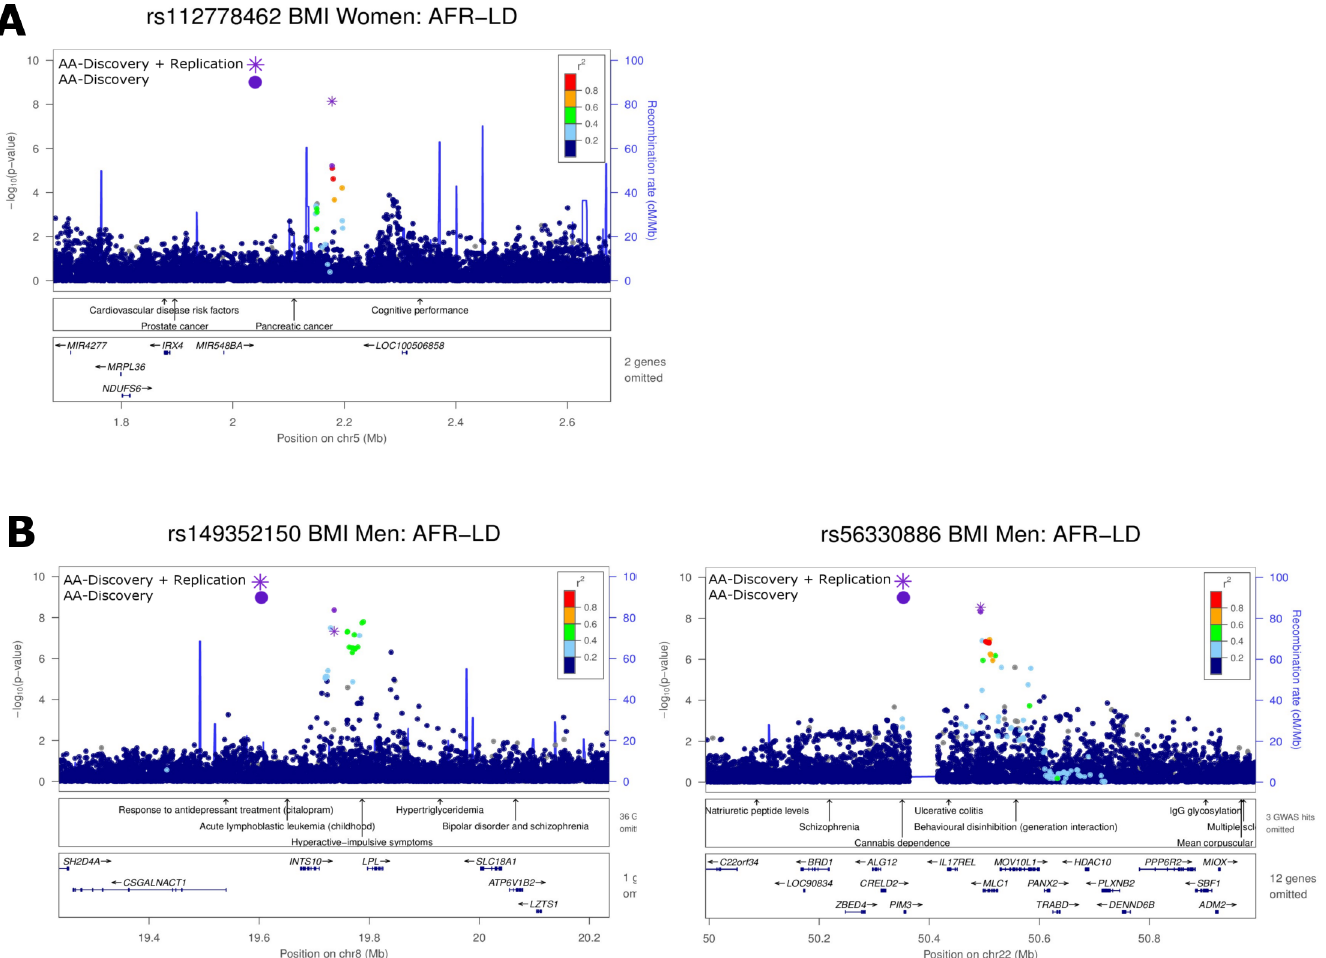
Fig 2. Locuszoomplots for three novel BMI loci: (A) IRX4/IRX2 in women only; and (B) INTS10/LPL and MLC1 in men only. All plots use AFR LD from the 1000 Genomes phase 1 reference panel. In each plot, the most significantvariant within a 1Mb regionallocus is highlighted. P -valuesfor all variants includingthe most significant variant are based on the African ancestry discovery phaseonly (AA-Discovery). In addition,for the most significantvariant, P - values are annotatedand illustrated from the African ancestry discovery and replicationphases (AA-Discovery+Replication).